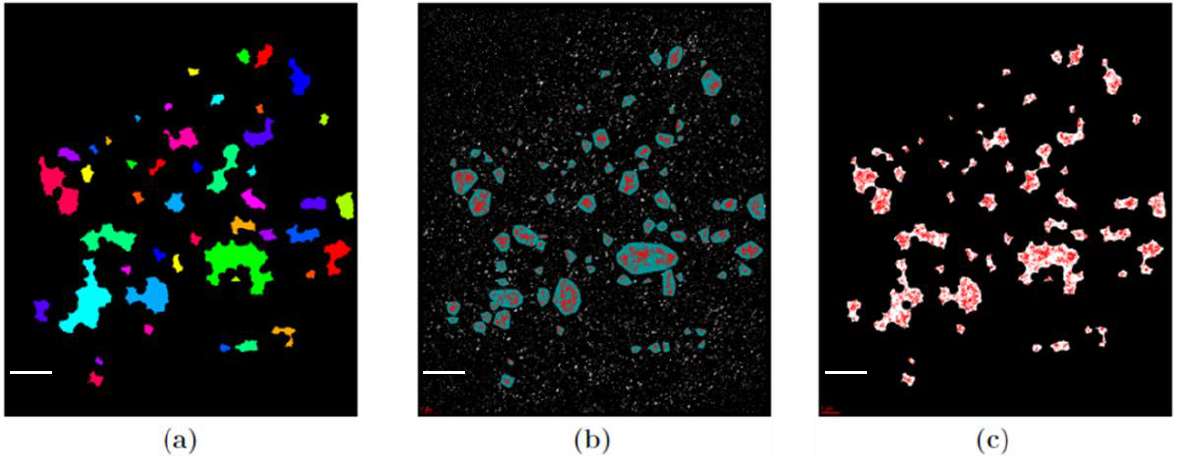
Figure 1. Example of images of γH2AX clusters after 180 min after 2 Gy irradiation of human skin fibroblasts. ( a ) Clusters detected by the original program used in [21]. ( b ) Cluster image obtained with the DBSCAN algorithm (cluster parameter values: N min = 110; ε = 200 nm). ( c ) The same image as ( b ) but with the closing function applied. The high co-incidence of ( a ) and ( c ) can be observed. Scale bar: 2 µm.